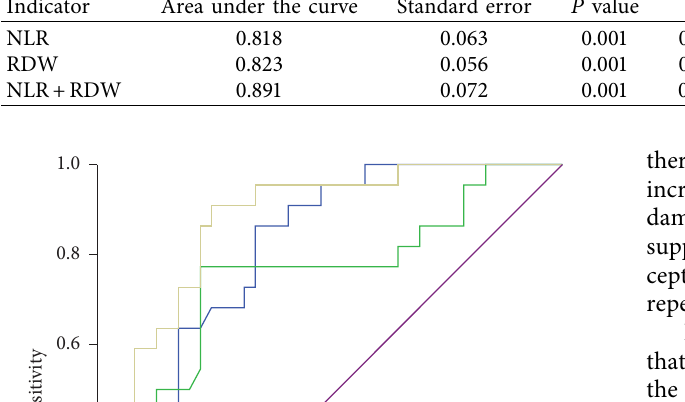
Table 4: Predictive value of NLR and RDW on the prognosis of emergency patients with sepsis. Indicator Area under the